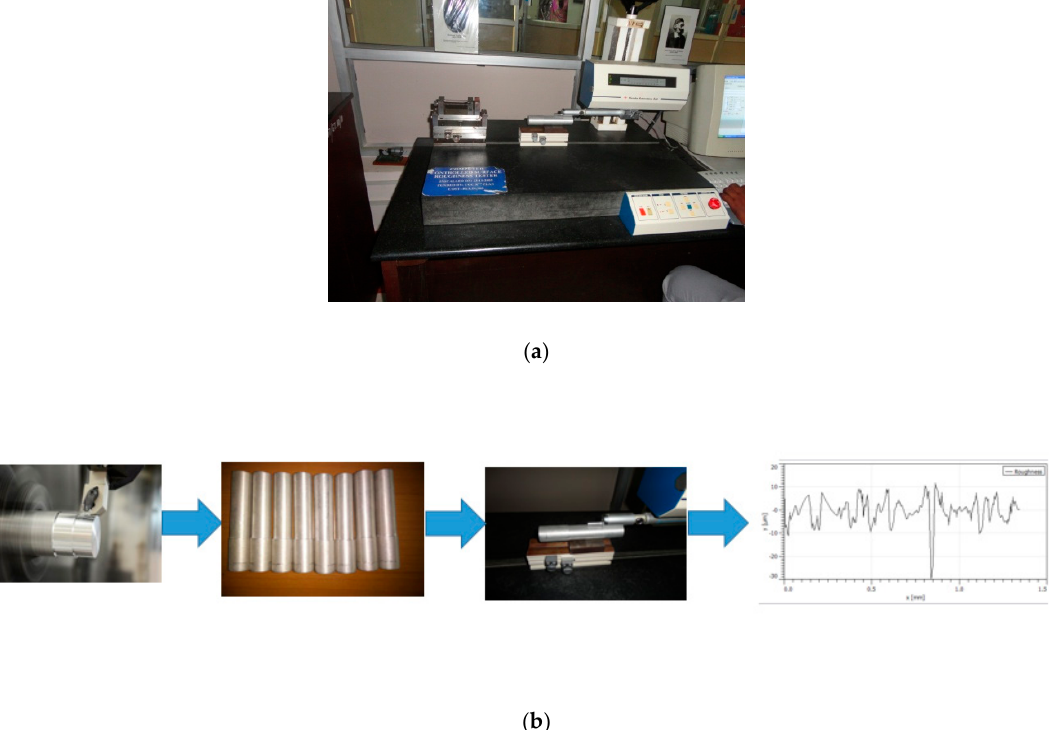
Figure 2. ( a ) Surface roughness testing ( b ) Flow chart of surface roughness measurement.